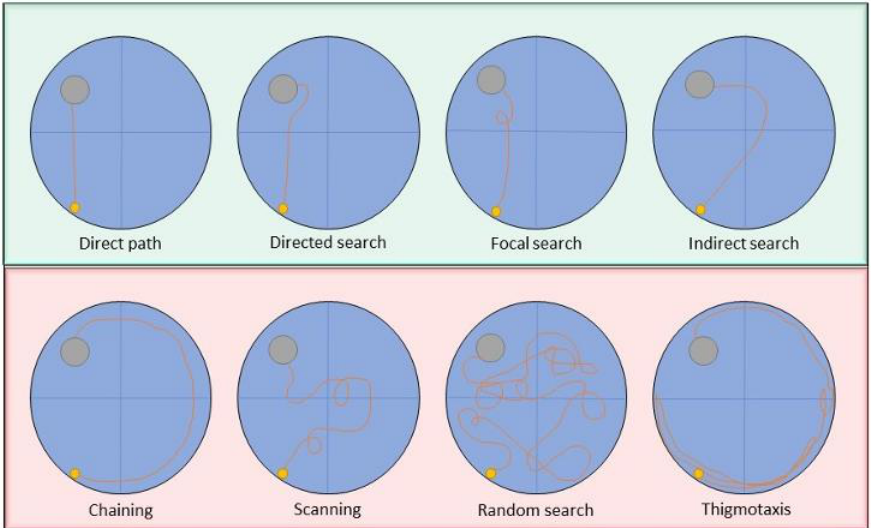
Figure 1. Search strategy classification by the Pathfinder system. Hippocampus-dependent strategies are also referred to as spatial strategies (green), whereas not-hippocampus-dependent are known as non-spatial strategies (red).